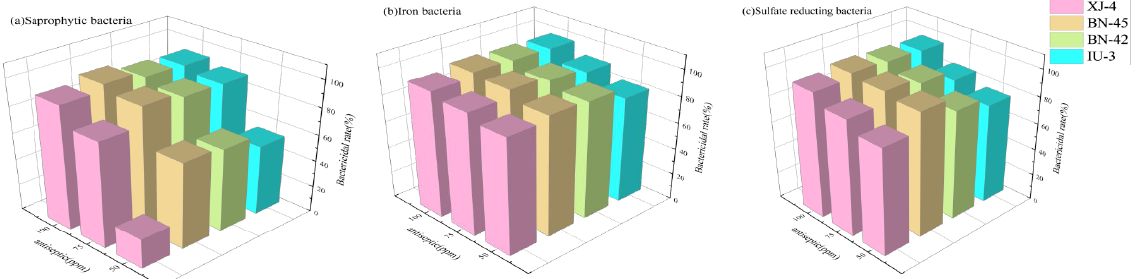
Figure 6. Sterilization rate of bactericides of different concentrations against bacteria. ( a ) saprophytic bacteria; ( b ) iron bacteria; ( c ) sulfate reducing bacteria.